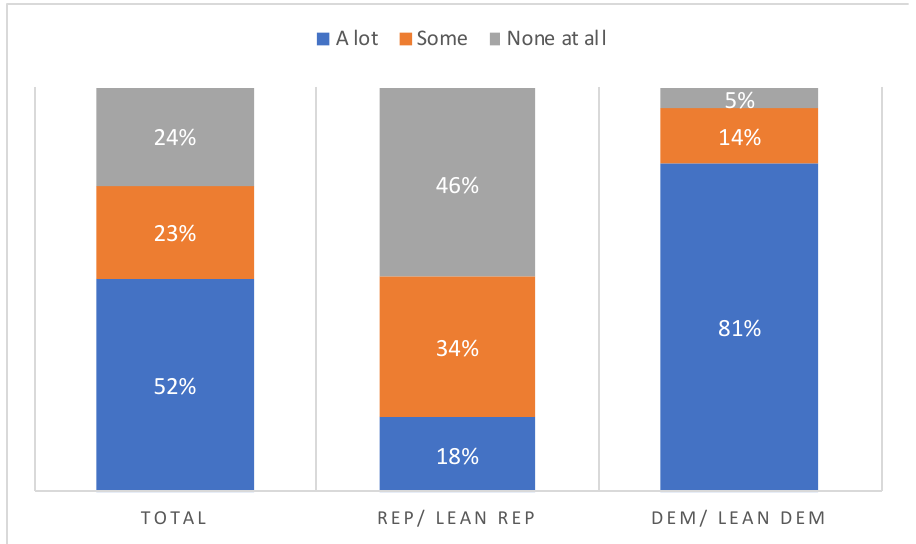
Figure 8. Citizens who consider Trump bears at least part of the responsibility for the Capitol disturbances. Source: Own elaboration from Pew Research’s American Trend Panel (2021).